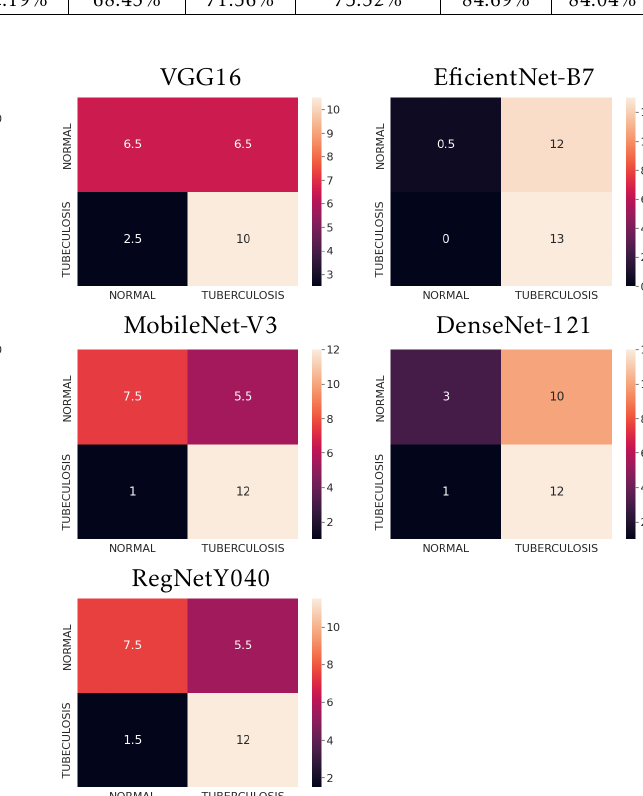
Figure 12. Confusion matrices for models applying to Montgomery Chest X-ray Set - MobileNetV3 provides the better results with True Positive and False Negative images detected are high - 7.5 and 12